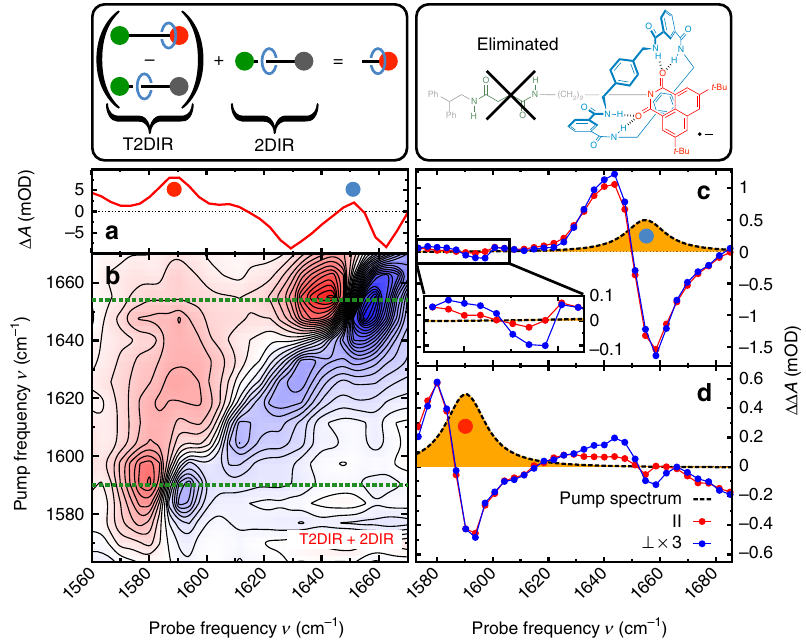
Fig. 5 Isolating the switched state of the molecular shuttle. a T1DIR spectrum of the molecular shuttle at t UV = 1000 ns. The colours of the dots indicating the different peaks correspond to the colours of the components of the molecular shuttle in the panels above, and in Fig. 2a. b Depletion-corrected T2DIR spectrum ( ΔΔ A ) of the molecular shuttle at t UV = 1000 ns. c Slice of the depletion-corrected T2DIR spectrum ( ΔΔ A ). The yellow peak is the power spectrum of the pump pulse, centred at 1654 cm − 1 . d Slice of the depletion-corrected T2DIR spectrum ( ΔΔ A ). The yellow peak is the power spectrum of the pump pulse, centred at 1592 cm − 1 . In each spectrum, the red curve is the spectrum measured with parallel ( || ) polarisations of the IR-pump ad IR-probe pulses. The blue curve is the spectrum measured with perpendicular ( ⊥ ) polarisations of the IR-pump and IR-probe pulses. The perpendicular signal in both T2DIR slices is multiplied by 3 for better comparison with the parallel